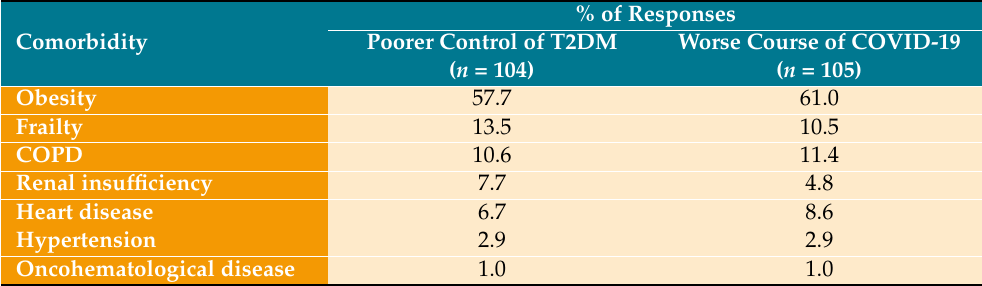
Table 2. Opinion on the impact of comorbidities on T2DM control or on the course of COVID-19 in patients with both diseases.